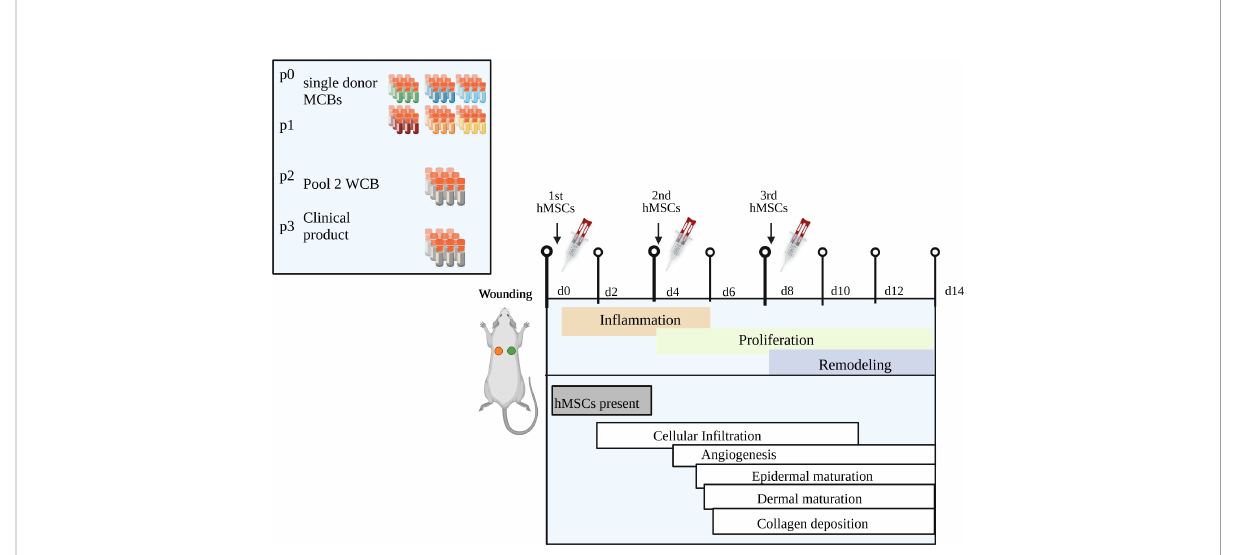
FIGURE 9 Summary of key fi ndings. Our novel clinical-scale manufacturing concept is comprised of six single donor hMSCs master cell banks that are pooled to a working cell bank from which an extrapolated number of 70,000 clinical doses of 1x10 6 hMSCs/cm 2 wound size can be manufactured within only three passages. Repeated topical hMSCs administration signi fi cantly accelerated the wound healing in a diabetic rat model by delivering a de fi ned growth factor cargo at the speci fi c stages of wound repair, namely in fl ammation, proliferation and remodeling. Speci fi cally, the hMSCs mediated epidermal and dermal maturation and collagen formation, improved vascularization, and promoted cell in fi ltration, especially a dynamic recruitment of M2 macrophages. Created with